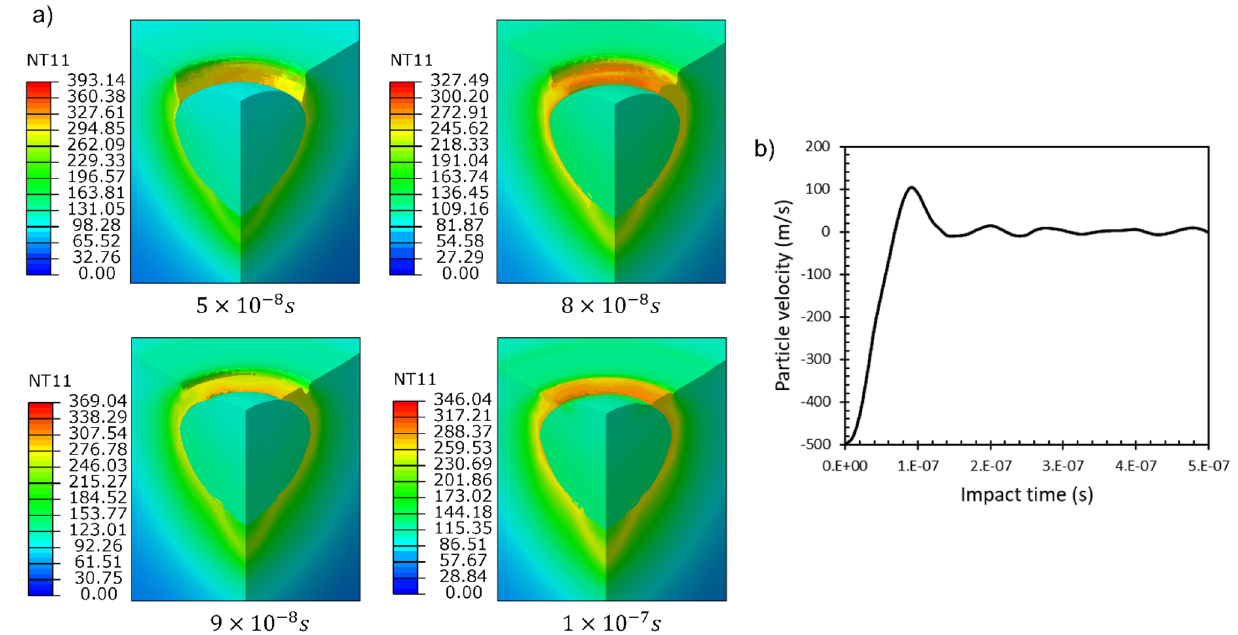
Figure 8. ( a ) Deformation stages of the substrate and particle during the impact with V p = 500 m / s after addition of the gas flow compensating effect ( b ) particle velocity variation as a function of impact surface of the particle (Fig. 7c). A 3D perspective is also provided in Fig. 7d at a later stage showing the developed covering layer. A Cu particle bonded to the PEEK substrate with a partial covering layer is shown in Fig. 7e from a closer view. Comparing Fig. 7d,e, indicates that with the improved model (modifying material behavior and also considering a superficial temperature gradient), the formation of a covering layer on the particle can be simulated successfully. With the continuation of the analysis time, however, it is found that the particle rebounds and eventually detaches from the substrate. The particle’s kinetic energy is so large during the rebound that the covering layer is torn off and the particle loses its bond with the substrate. The results showed that the deformation of PEEK in correspondence to the crater depth is lowered ( 14 µ m ) in comparison to the original model with the same temperature gradient field (Fig. 6b). This originates from the enhancement in material hardening, especially at low temperatures. However, by adding the softening behavior at temperatures close to the melting point, the extrusion of the covering polymer was modeled correctly. Because the covering layer in the numerical model is not able to retain the particle in place and prevent the detachment, it is logical to think of another possible contributing factor for a successful bonding of the particles. This aspect becomes more important to model also the case of those interlocked particles, which turn out to have almost no covering layer on the top (Fig. 4a). It is postulated that this could be, to some extent, caused by the continuous high-speed flow of the propellent gas during deposition. The extruded polymer layer that partially covered the particle perimeter is softened due to high temperatures (as evident in Fig. 4b,c) and thus can be easily deformed under the continuous expanding gas flow. For the cold spray processing parameters utilized in this study, a gas velocity of 50 m / s and a gas pressure of 0.7 MPa are predicted by the KSS software in the zone very close to the substrate surface. This gas flow can deform the “hot polymer” making a barrier for the particle rebound and hindering it from detaching. Thus, the flattened and squeezed covering layer in Fig. 4c could be induced by the gas flow effect. To model such a contribution from the gas flow, an infinitesimal velocity boundary condition ( V y = − 1 × 10 − 15 m / s )was applied in the vertical direction to all the Eulerian elements located higher than the initial surface level in the center within a radius 2 times that of the particle. Initially, this region is without any material, representing an Eulerian void. This boundary condition was applied to the deforming PEEK as it flowed into this region. The results of the simulation are shown in Fig. 8. At the time interval of 5 × 10 − 8 s , the particle achieved its maximum penetration and started rebounding. It is observed that the extrusion of the PEEK layer already started at the interface of the particle and the crater. Since the PEEK material was extremely softened, it flowed and filled the gap between the extruded layer and the surrounding polymer (at 8 × 10 − 8 s and 9 × 10 − 8 s ). At 1 × 10 − 7 s , the gap was filled, and the deformation stopped due to the counterbalancing effect from the gas flow. The particle’s velocity reduced to zero at longer analysis times (Fig. 8b). This analysis shows an interlocked particle with a very small partial covering layer over the particle perimeter and no excess gap below the particle, similar to what was observed in our experimental wipe-tests (Fig. 5). The addition of the gas flow effect also removed the creation of any bulge out of the initial surface in the surrounding substrate, which lowers the final penetration depth, making it closer to the experimental observations (Fig. 6).